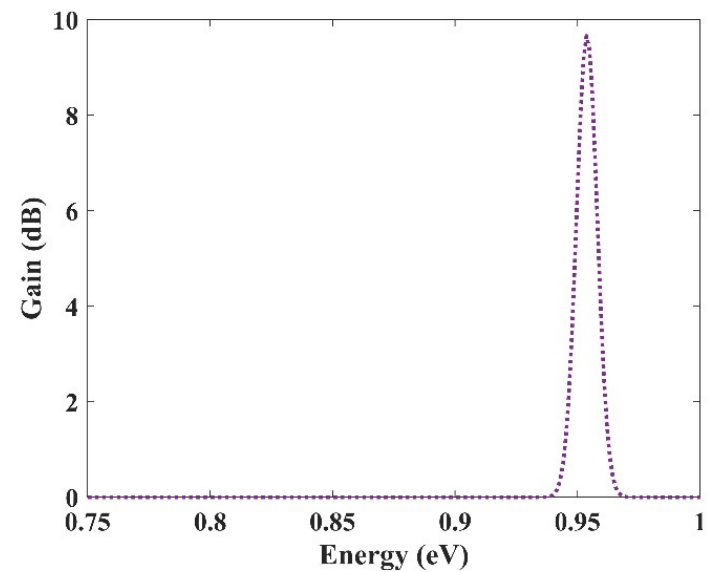
Figure 14. Selective amplification for channel 3 (1310 nm).